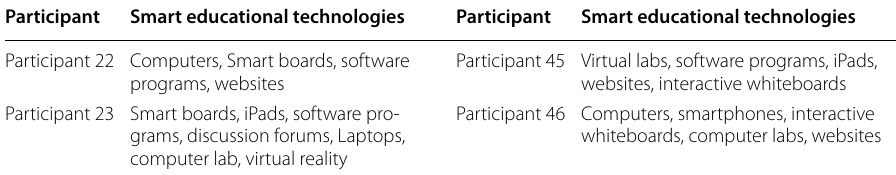
Table 5 Academics’ responses regarding the frequency they use various smart educational technologies in their educational activities